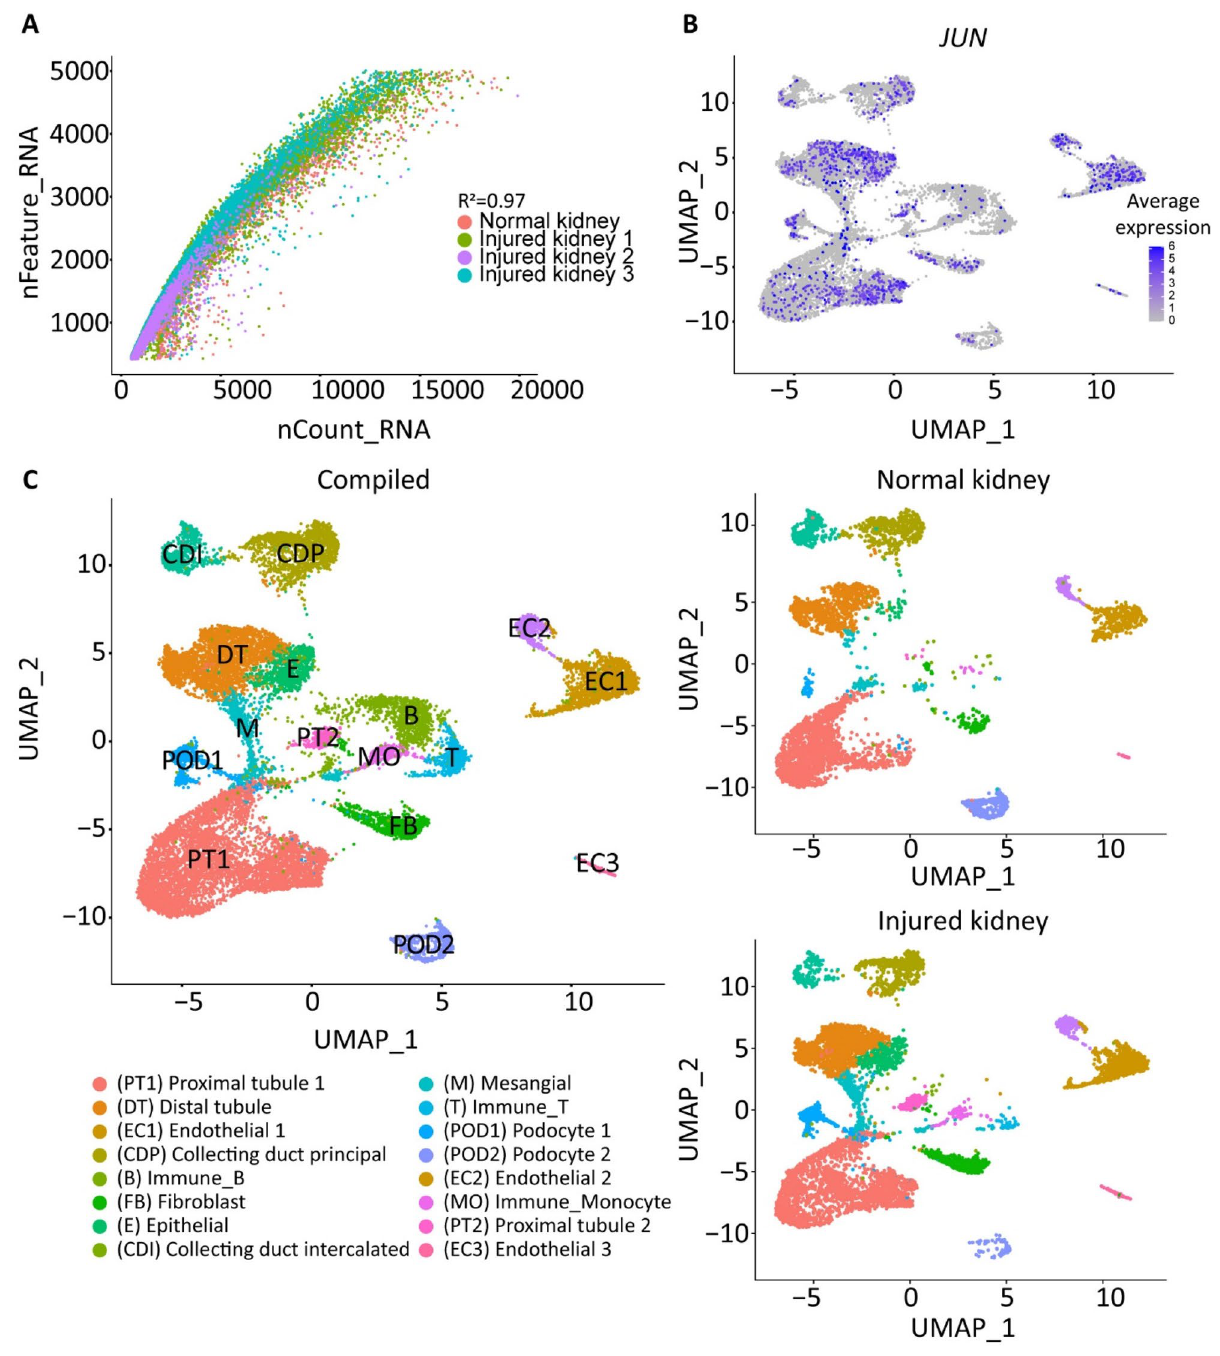
Figure 4. Assessment of single nuclei quality after snRNA-seq. ( A ) Dot plot representation of the relationship of the number of genes detected (y-axis) against the total number of RNA reads (x-axis). R 2 = 0.97. ( B ) Average expression of JUN stress response pathway across each cell population. ( C ) (left) UMAP visualization of a total of 13,075 nuclei partitioned into 16 clusters from a total of 5 human kidneys after quality control filtering. Each cluster is labeled by color. (right) Individual UMAP visualization of the normal and injured kidney